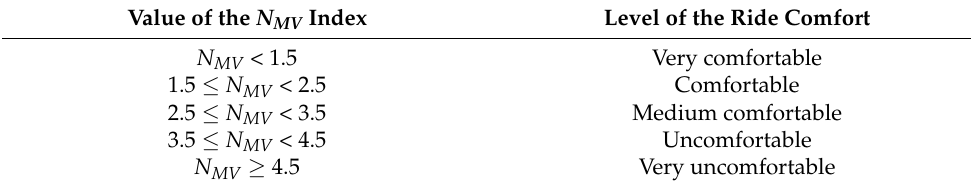
Table 2. A scale for evaluating the ride comfort index N MV